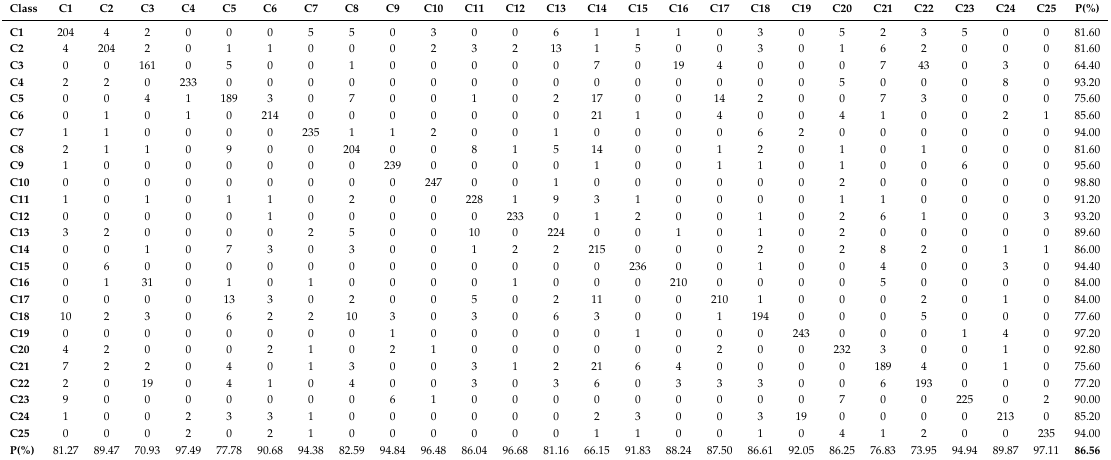
Table 6. Confusion matrix of classification results based on ADCC64.